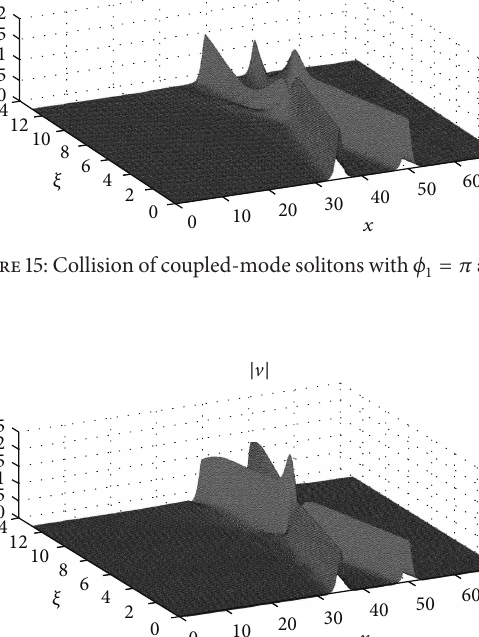
Figure 14: Contour plot of the collision of solitons in Figure 12.